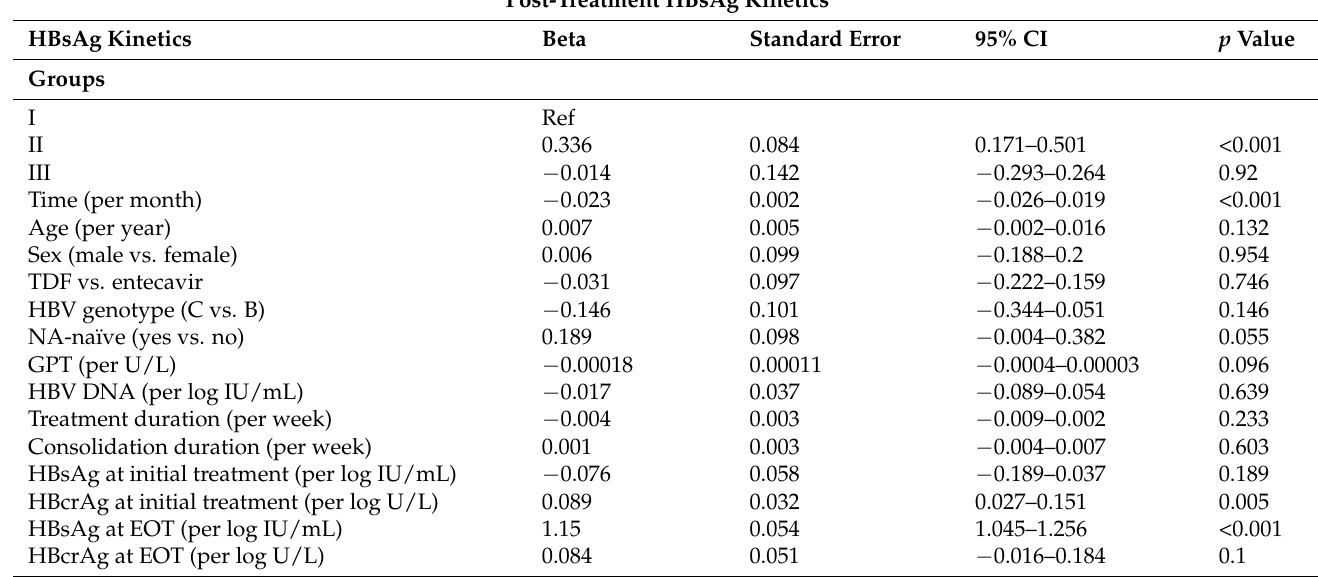
Table 3. Multivariable analysis of post-treatment HBsAg change by generalized estimating equa- tions